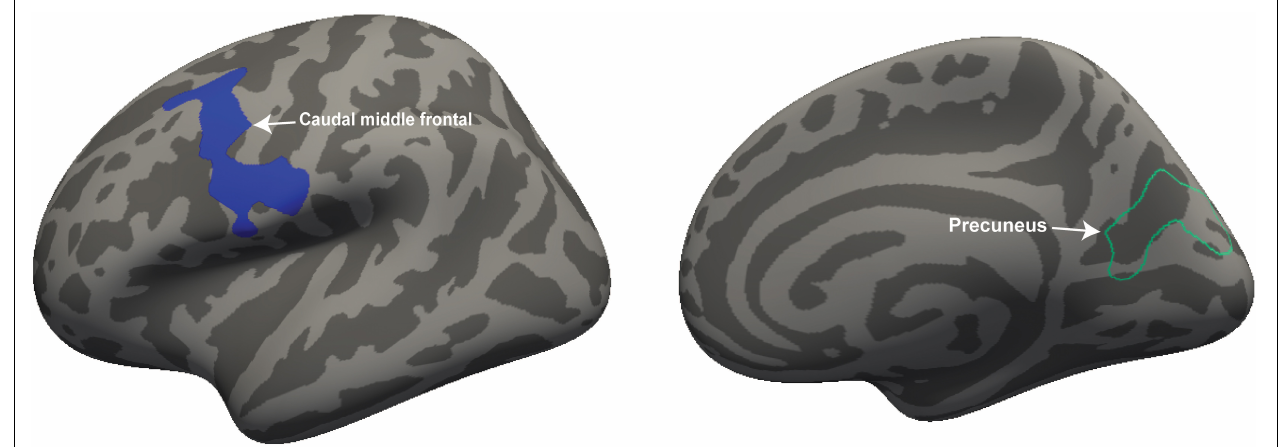
FIGURE 1 | Volume and thickness reduction in ME/CFS patients. Volume was reduced in the left caudal middle frontal (white arrow) and thickness in the right precuneus region (white arrow) of ME/CFS patients compared with HC. The volume is represented with filled blue color whereas thickness is represented by unfilled green color. Significant volume and thickness clusters were overlaid on the inflated brain (left and right hemisphere) available in FreeSurfer.